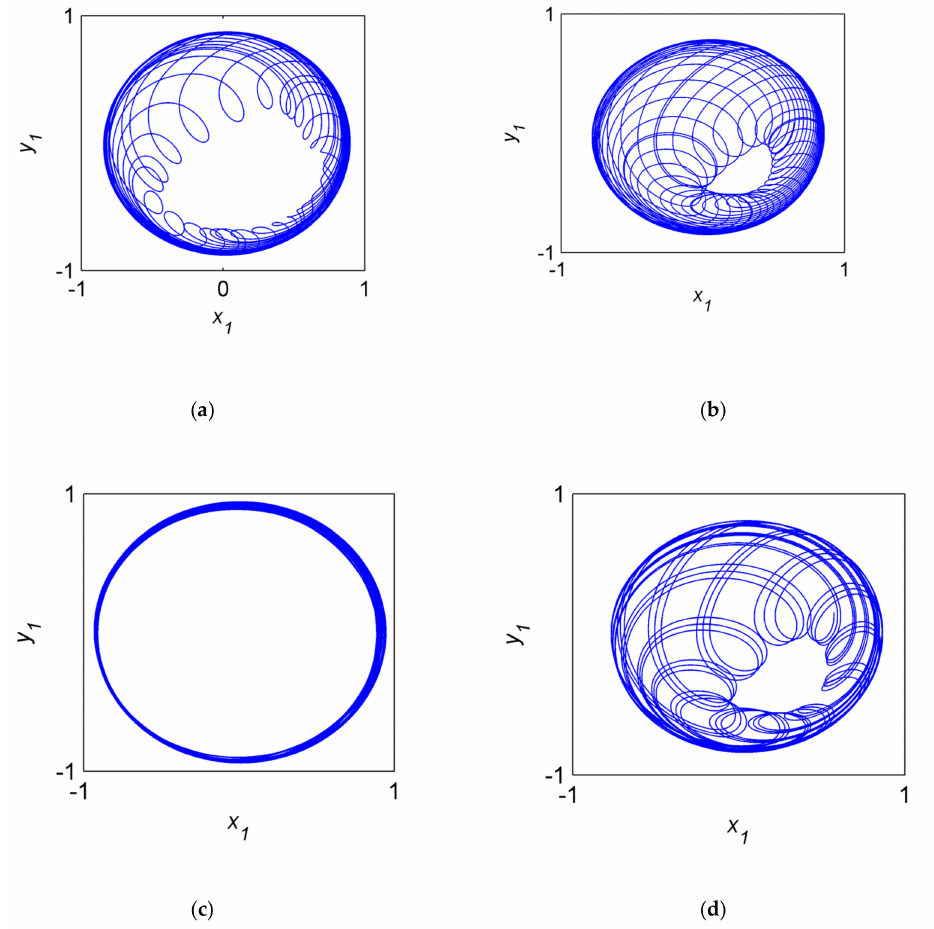
Figure 12. Trajectories of the orbit of shaft center of o 1 when ω = 1020 rad/s. ( a ) The oil-filmed system. ( b ) The cracked system. ( c ) The rub-impacted system. ( d ) The coupled